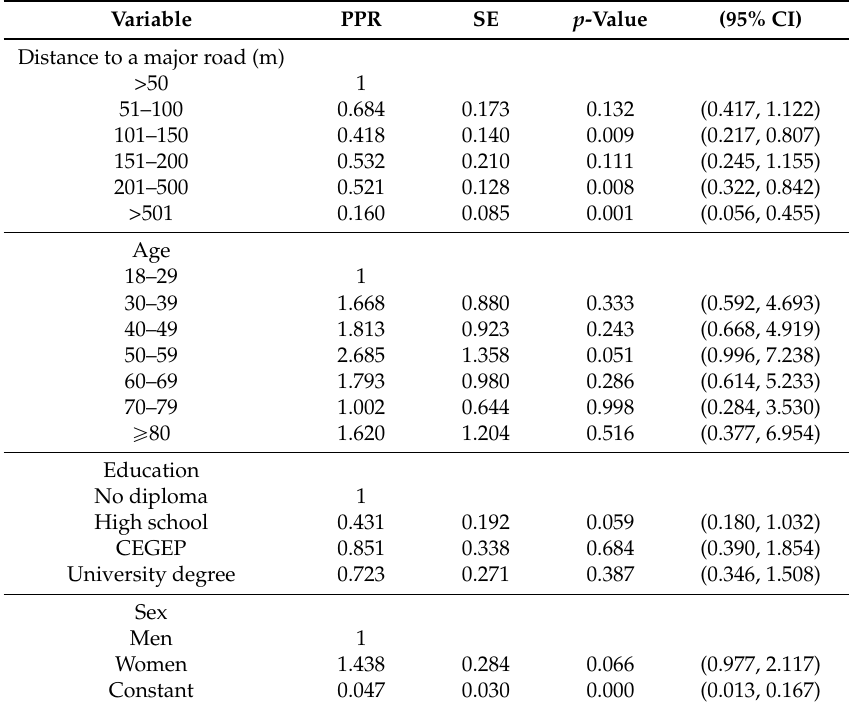
Table A2. Log-binomial regression models for sleep disturbance due to road traffic in relation to the distance to major roads. All variables are in a same model.